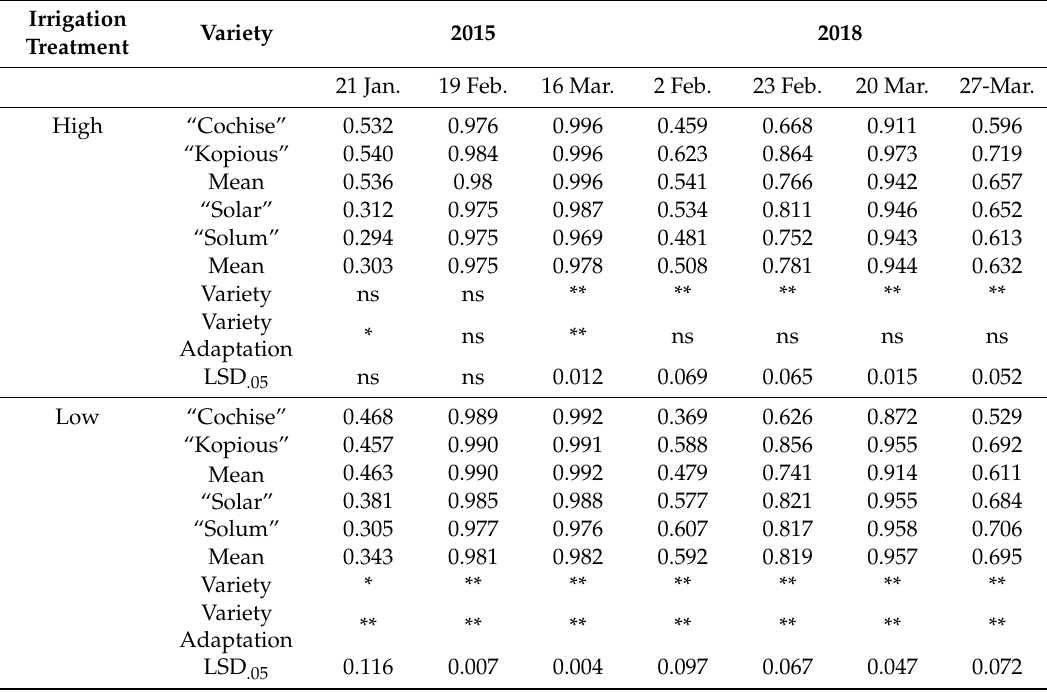
Table 3. E ff ect of irrigation treatment on the fraction of photosynthetically active radiation (PAR) intercepted by barley for trials conducted in Tucson in 2015 and